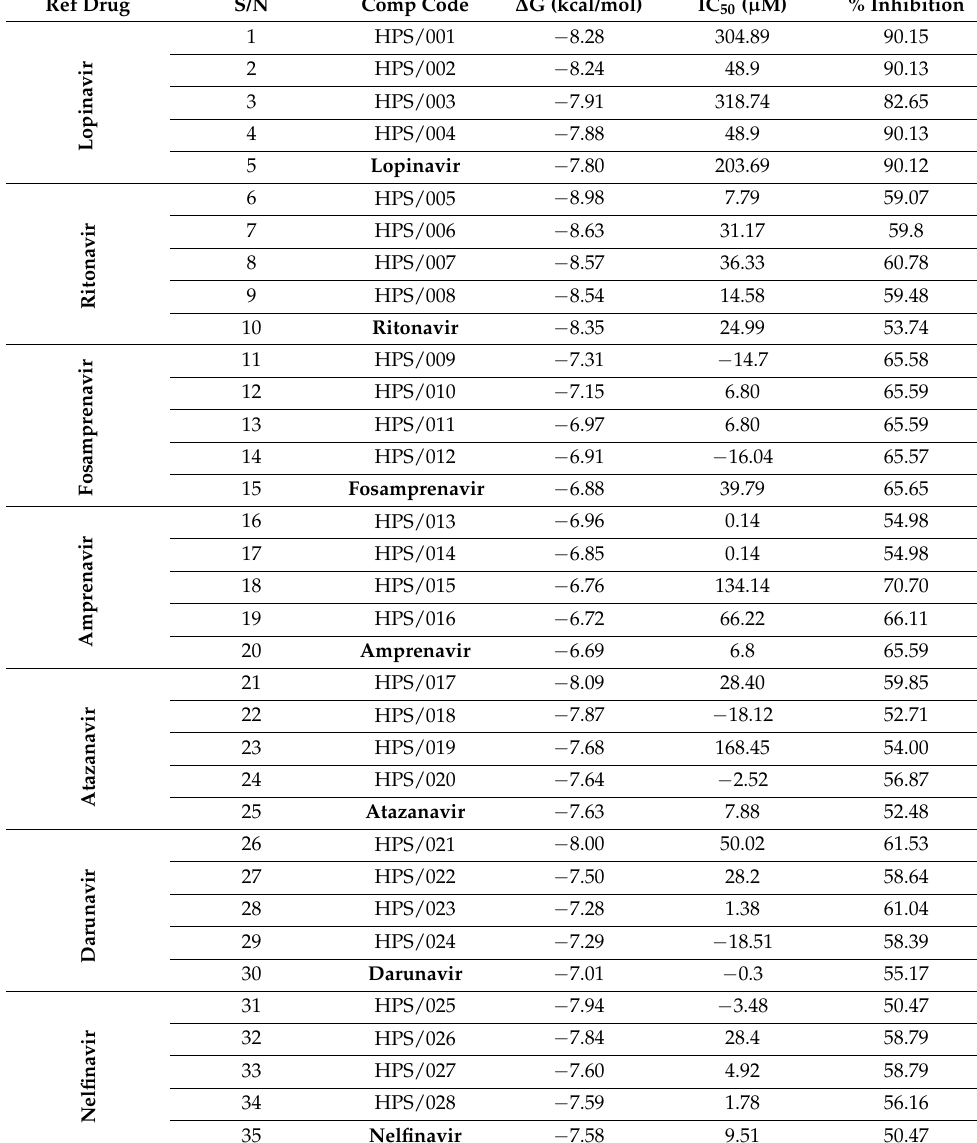
Table 2. Binding free energy (kcal/mol) and the HIV protease inhibitory activity of selected hits from different reference